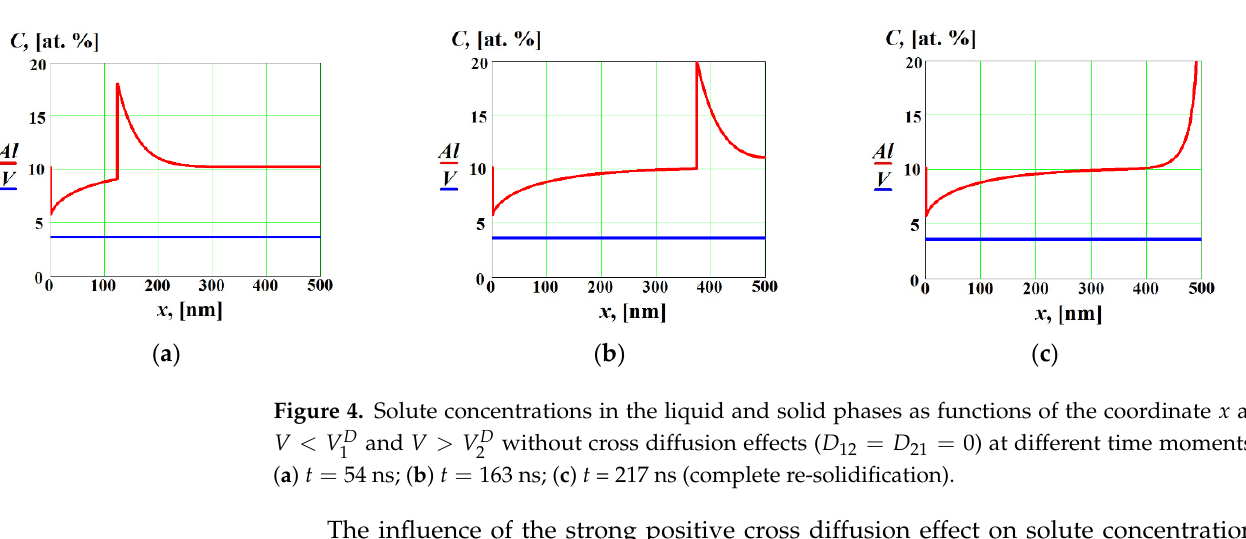
( a ) t = 54 ns; ( b ) t = 163 ns; ( c ) t = 217 ns (complete re-solidification).